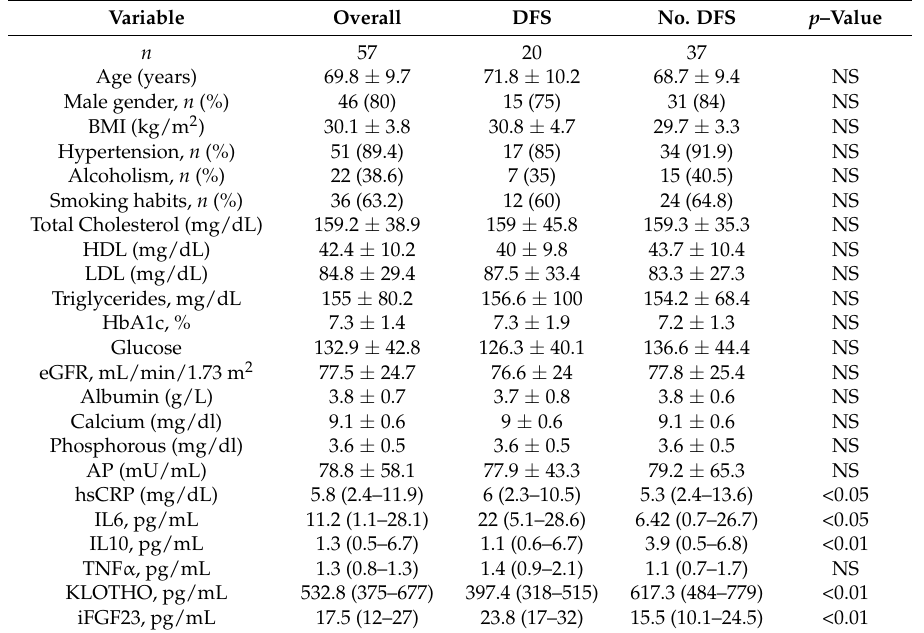
Table 1. Clinical characteristics and biochemical assessments of the diabetic patients included in the study.